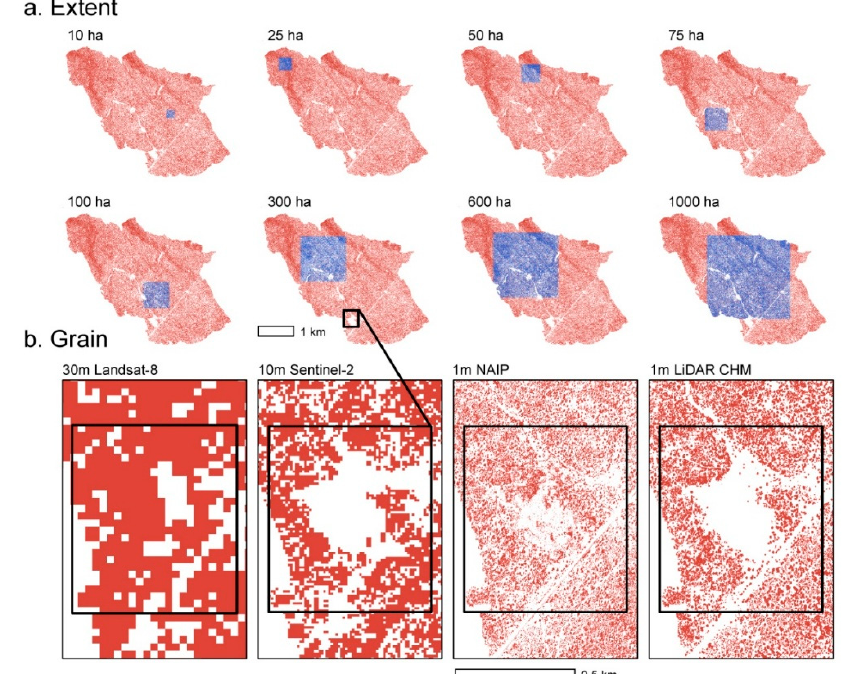
Figure 2. Remotely sensed data products and associated grain of each data source: Landsat-8 (30 m), Sentinel-2 (10 m), NAIP (1 m), and LiDAR (1 m). The top panel ( a ) shows the canopy cover of Windmill Draw landscape, with the blue areas representing the relative size of each extent (10–1000 ha) analyzed. The lower panel ( b ) shows size of the spatial grain (resolution) and level of information available for each data product within an example extent. Table 1. Description of landscape metrics evaluated across grain and extent on three landscapes in northern Arizona, USA. Metrics derived from FRAGSTATS (www.umass.edu / landeco / research / fragstats /